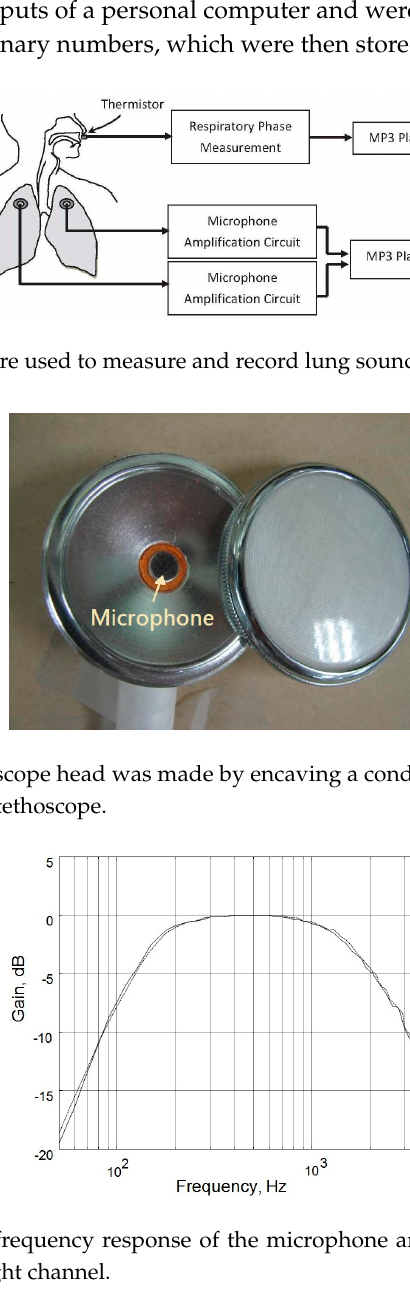
Figure 3. The normalized frequency response of the microphone amplification circuit. Solid line: left channel; dashed line: right channel.